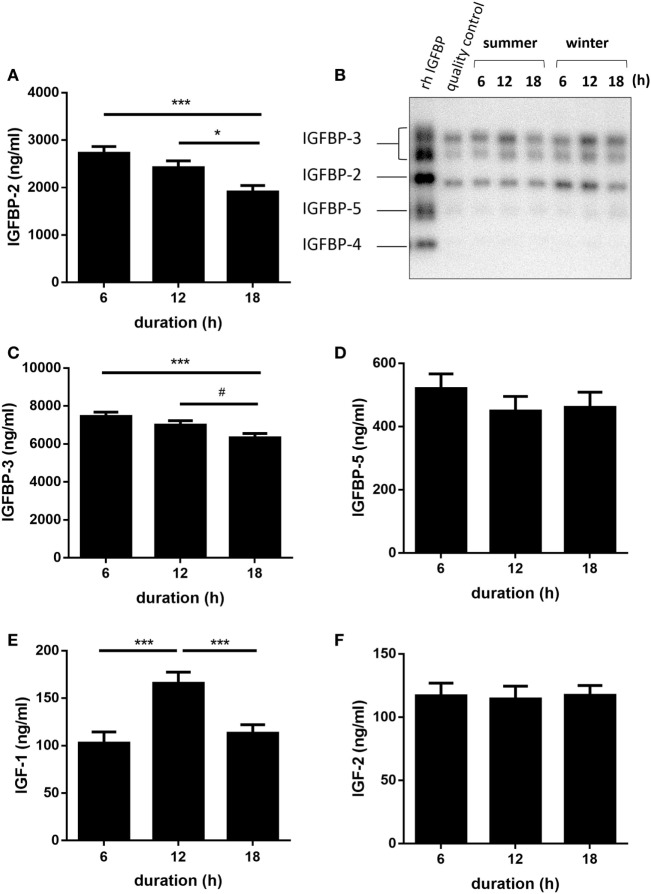
Effect of transport duration on insulin-like growth factor (IGF)-axis: insulin-like growth factor-binding protein (IGFBP)-2 (A), with kind permission from Nature Publishing Group as previously published in Ref. (9), IGFBP-profile (B), IGFBP-3 (C), IGFBP-5 (D), IGF-I (E), and IGF-II (F). Quantitative data are presented as LS-Means + SE and include the summarized data of the trials in January/February and July due to the absence of the significant interaction duration × environment (*p < 0.05, **p < 0.01, ***p < 0.001, #p < 0.1, rh: recombinant human, quality control: pig plasma sample). IGFBP-2, -3, -5: n = 80 per duration; IGF-I and IGF-II: n = 30 per duration.